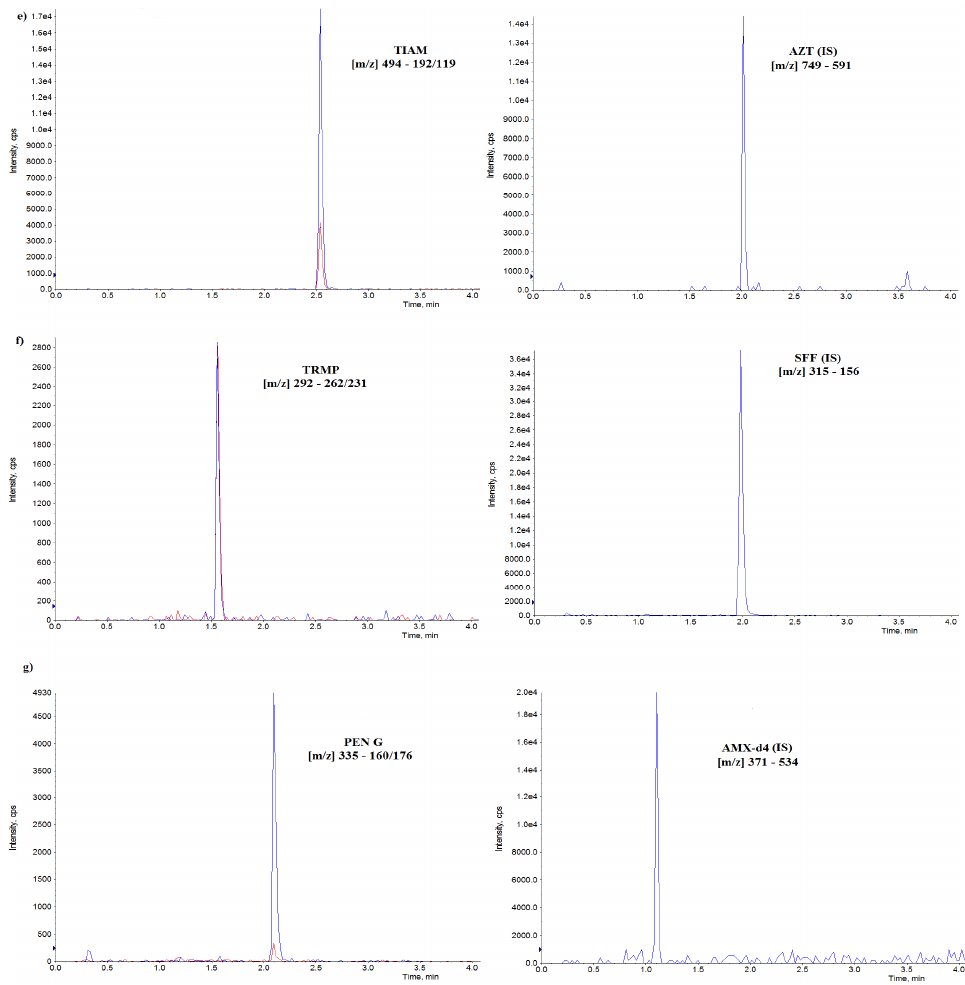
Figure 1. Chromatograms of oral fluid samples spiked at validation level (VL) with analysed compounds and corresponding internal standards (IS), ( a ) AMX—amoxicillin, ( b ) TYL—tylosin, AZT—azithromycin, ( c ) LIN—lincomycin, ( d ) SDX—sulfadoxine, SFF—sulfaphenazole, ( e ) TIAM—tiamulin, ( f ) TRMP—trimethoprim, ( g ) PEN G—penicillin G.